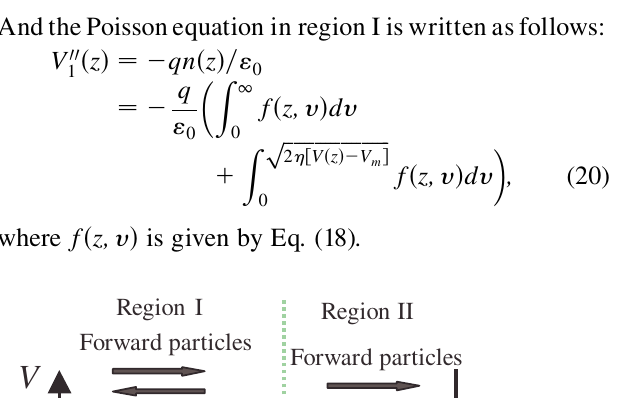
FIG. 7. (Color) Response of the energy analyzer due to the space-charge force. (a) Collector signal. (b) Beam energy